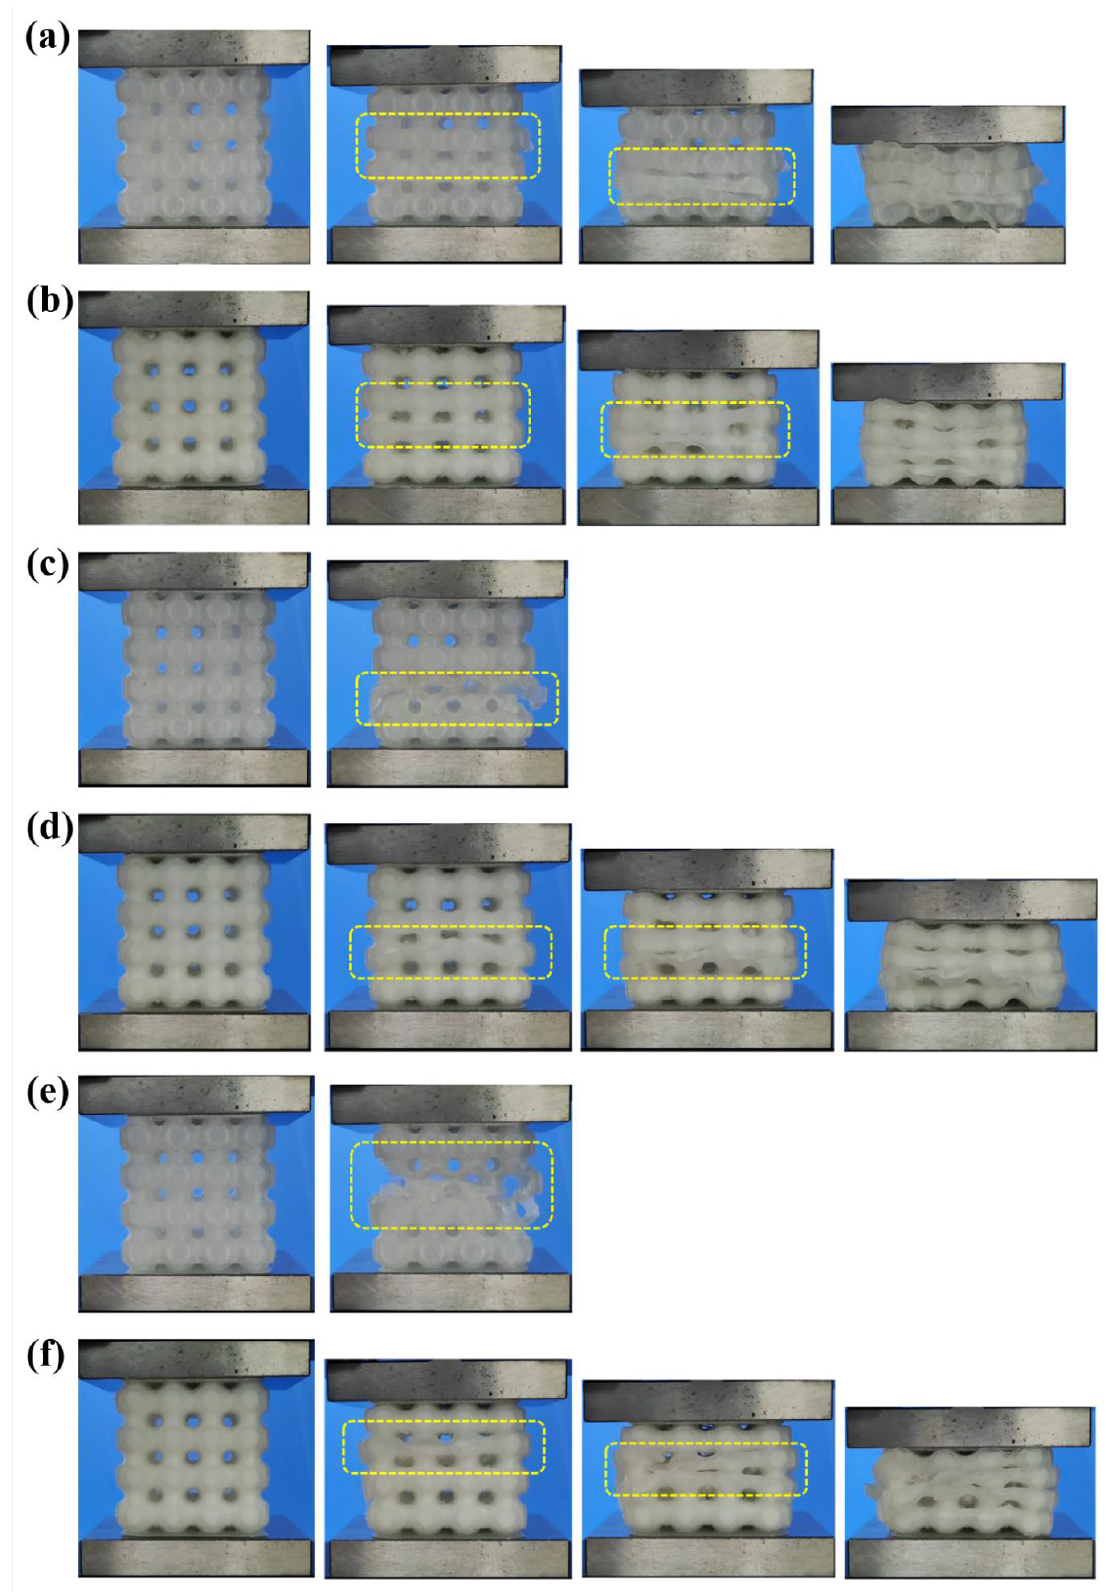
Figure 7. Deformation pattern of unfilled and foam-filled lattice structures at ( a , b ) 0.125 s − 1 , ( c , d ) 1.25 s − 1 , ( e , f ) 2.5 s − 1 .